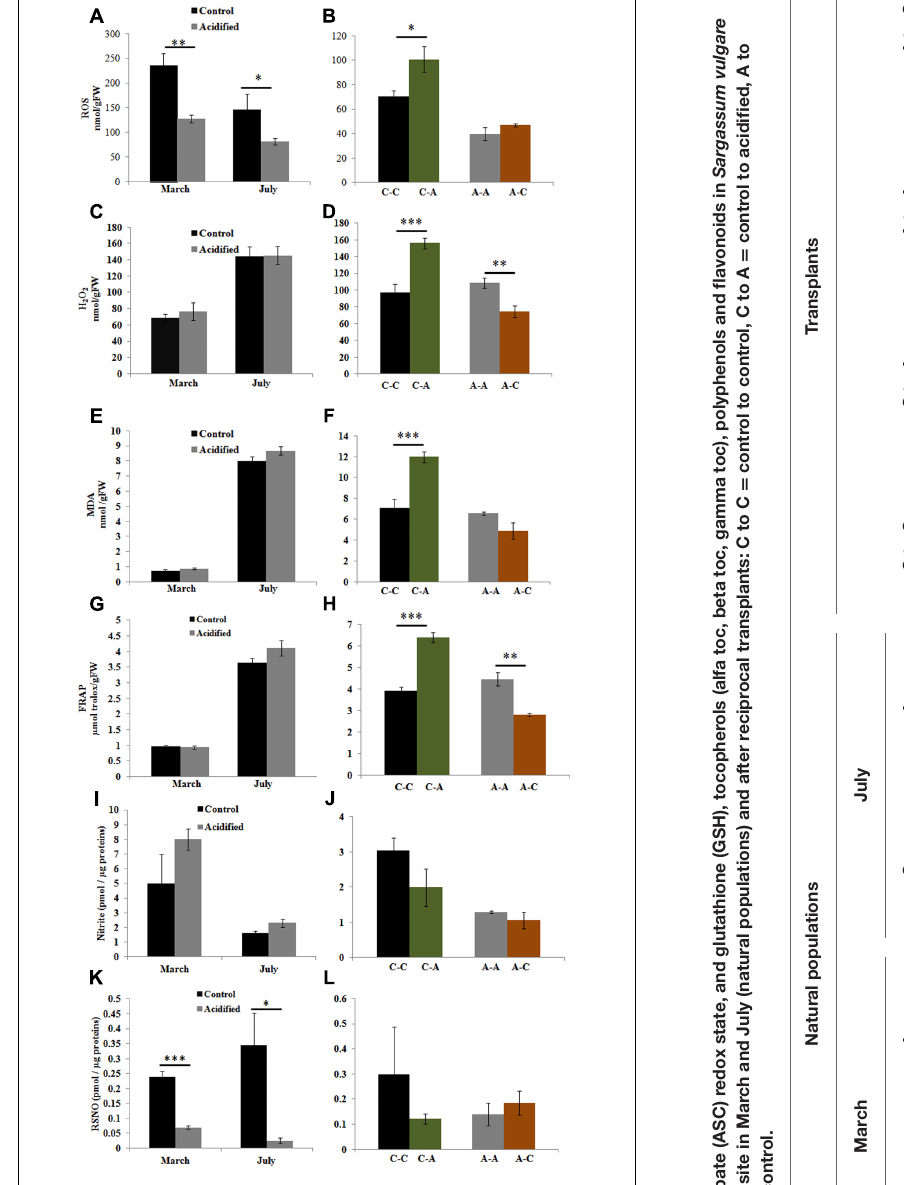
FIGURE 2 | Reactive oxygen species (ROS), hydrogen peroxide (H 2 O 2 ), lipid peroxidation [malondialdehyde (MDA)], total antioxidant capacity [ferric reducing/antioxidant power (FRAP) assay], nitric oxide (nitrite), and protein nitrosothiol (RSNO) levels in S. vulgare samples collected at the control and the acidified site in March and July (natural populations) (A,C,E,G,I,K) and in transplants (B,D,F,H,J,L) . C-C = control to control, C-A = control to acidified, A-A = acidified to acidified, A-C = acidified to control. Values are mean ± SE, n = 3 ( n = 5 for ROS, nitric oxide, and RSNO), ∗ p < 0.05, ∗∗ p < 0.01, ∗∗∗ p <